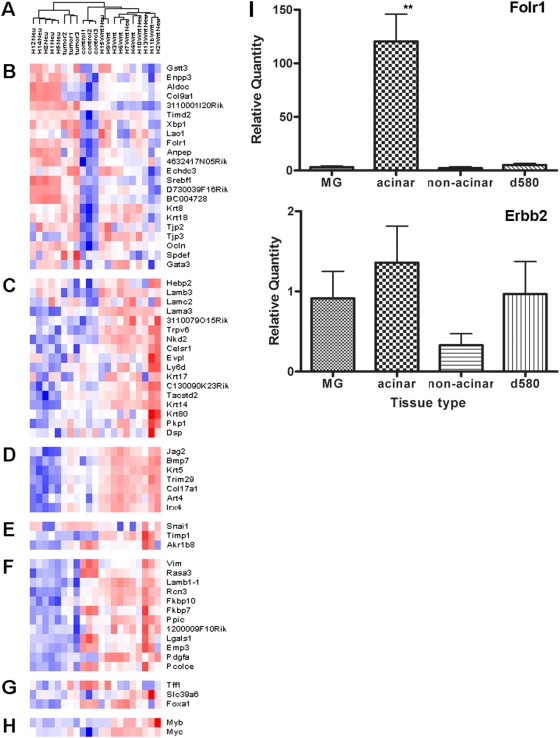
Comparison of expression profiles of K14-cre; ApcCKO/+ mammary tumors to MMTV-Wnt1 and MMTV-Neu tumors.(A) Dendrogram of K14-cre; ApcCKO/+, MMTV-Wnt1, MMTV-Neu and MMTV-Wnt1/Neu tumors [26], based on hierarchical clustering analyis of Affymetrix microarray data. K14-cre; ApcCKO/+ acinar mammary tumors (tumor 1, 2, 3) showing more correlation to MMTV-Neu. (B–G) Mouse models intrinsic gene set cluster analysis, as depicted in Herzchkowitz et al [25]. Red and blue indicate expression levels respectively above and below the median. The magnitude of deviation from the median is represented by the color saturation. (B) Luminal epithelial gene expression pattern. (C) Genes encoding components of basal lamina. (D) A second basal epithelial cluster genes. (E) Genes implicated in epithelial to mesenchymal transition. (F) A second mesenchymal cluster that is expressed in normal. (G) Estrogen-regulated genes. (H) Potentially estrogen-regulated genes. (I) Real-time RT-PCR analysis of Folr1 and Erbb2 transcript levels in mammary tumors of the K14-cre; ApcCKO/+ and ApcΔ580/+ mice. Bars represent the mean values±S.E.M. for 7 control mammary glands (MG), 12 acinar and 6 non-acinar (undifferentiated or basosquamous) K14-cre; ApcCKO/+ and 4 ApcΔ580/+ (d580) mammary tumors normalized to the Hprt1 transcript levels. The difference in the Folr1 transcript levels was statistically significant between the control only in the acinar-type K14-cre; ApcCKO/+ mammary tumors (p<0.006), whereas no difference was detected for the Erbb2 transcript levels between the tumors and the control.